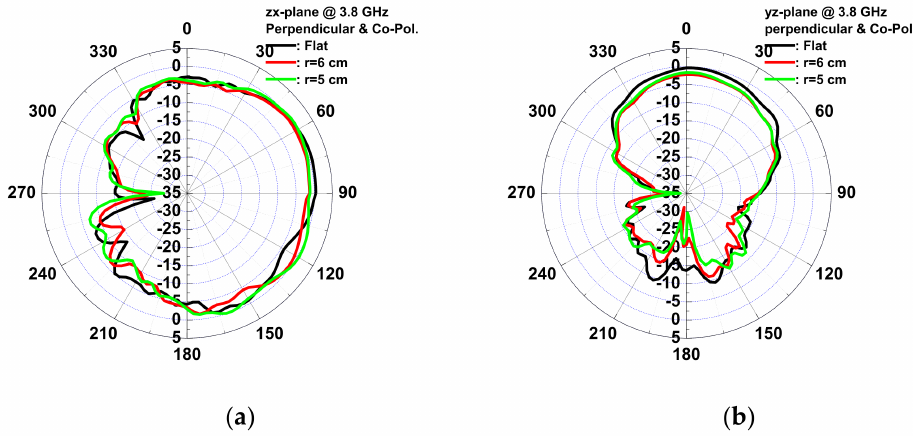
Figure 17. Measured copolarization radiation patterns of the antenna for perpendicular bending with dipole in ( a ) the zx-plane and ( b ) the yz-plane at 3.8